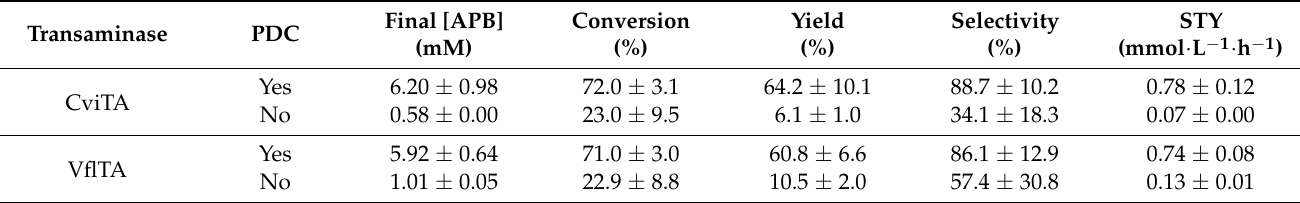
Table 2. Process metrics of 3-APB synthesis. Reaction conditions: reaction time 8 h; temperature 30 ◦ C; pH 7.5; 4-PB 10